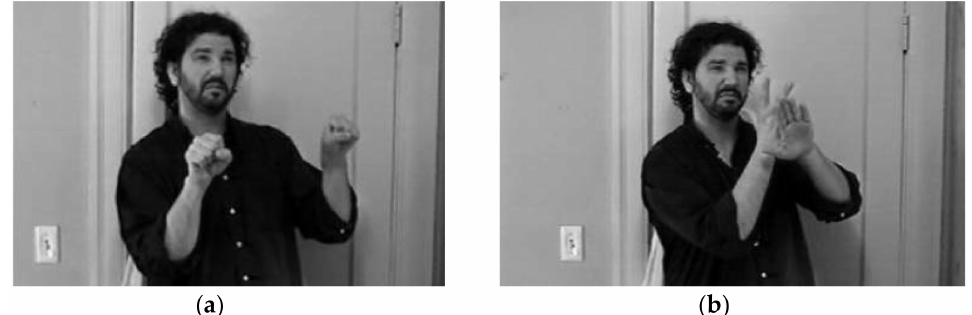
Figure 2. Classifier usage [18]. ( a )The motorcyclist. ( b ) driving up a